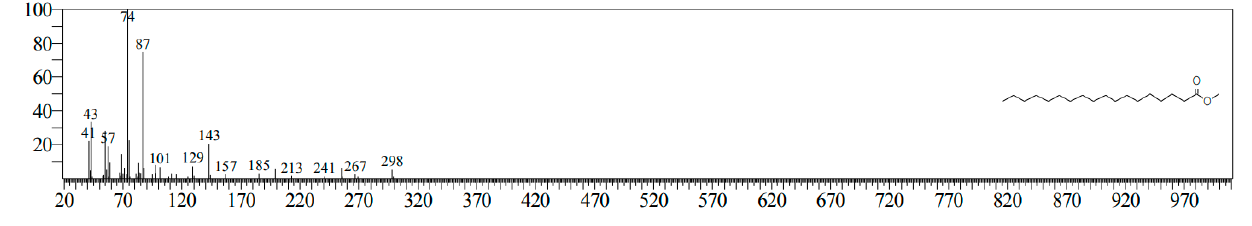
Figure 12. Comp Name: Methyl stearate, Run Time: 17.664, Mol Weight: 298.